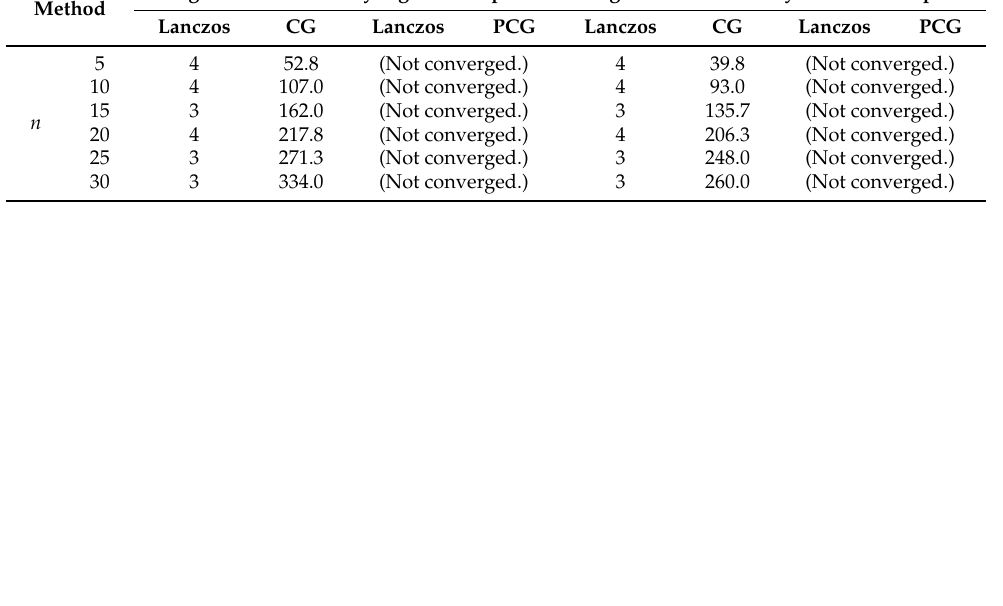
Table 8. Number of iterations of the Lanczos method and the average of numbers of iterations of the CG/PCG method in the case of the 5-th max. singular value of marginally symmetric matrix T with a = c = 1 and b = 0.2 in (9) for the shift (8). Algorithms 1 and 3 (by Eigendecompn.) Algorithms 1 and 4 (by Schur Method